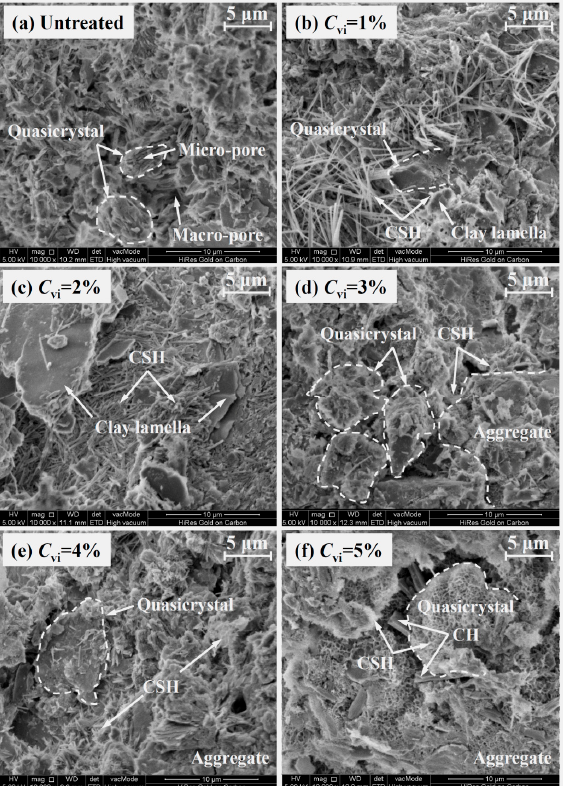
Figure 13. SEM images of saturated untreated and cement-treated GRSs cured to 28 d.